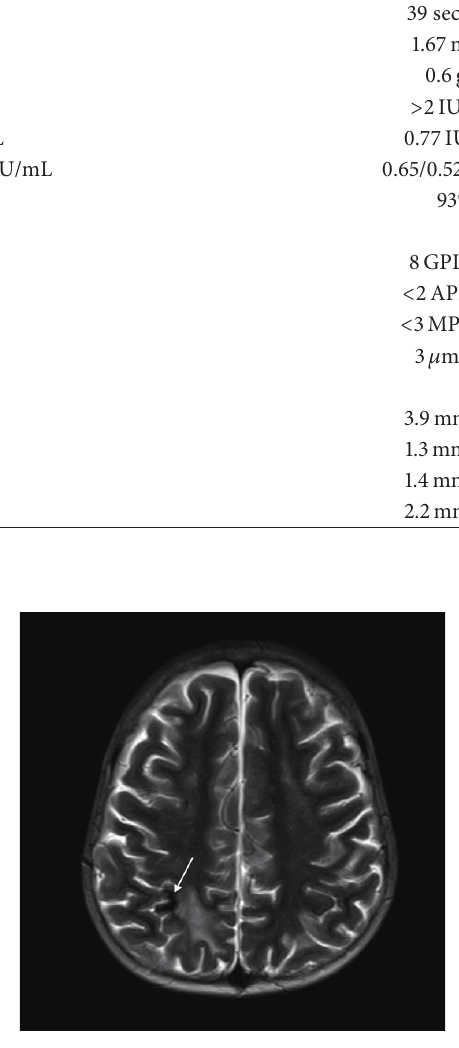
hemorrhage (arrow) in right frontal lobe with resolution of previous ischemic